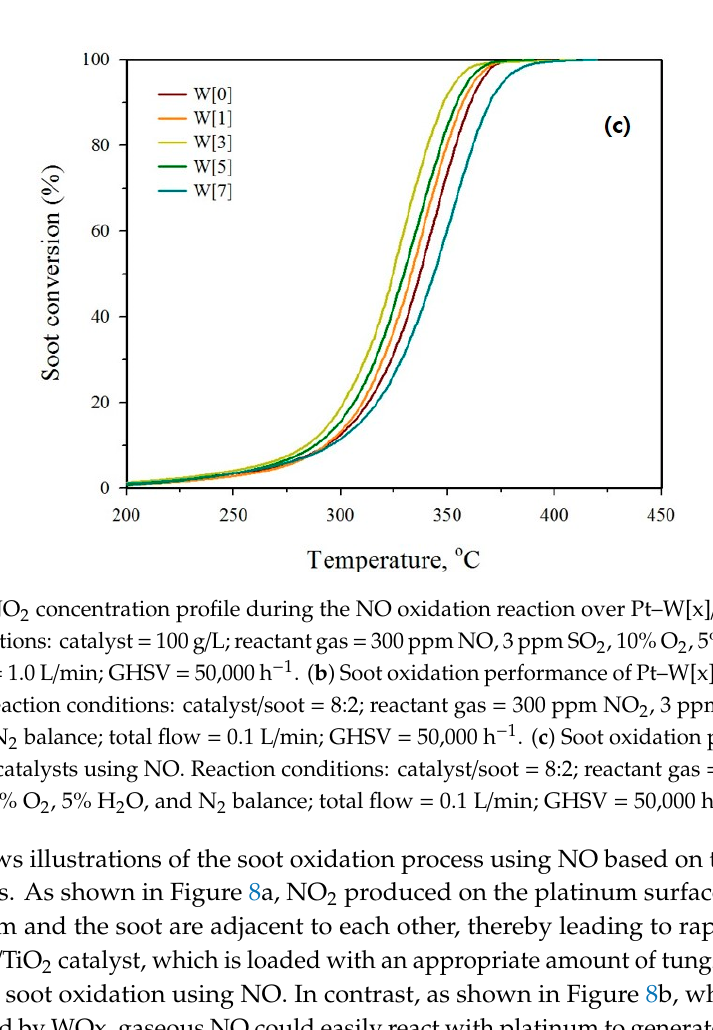
Figure 9. Temperatures corresponding to soot conversion rates of 10% (T 10 (°C)) and 20% (T 20 (°C)) as a function of the tungsten content in Pt–W[x]/TiO 2 catalysts. Reaction conditions: catalyst/soot = 8:2; reactant gas = 300 ppm NO, 3 ppm SO 2 , 10% O 2 , 5% H 2 O, and N 2 balance; total flow = 0.1 L/min; GHSV = 50,000 h − 1 . 3. Materials and Methods 3.1. Catalyst Preparation Degussa P-25 was used as the TiO 2 support, ammonium paratungstate (APT, [(NH 4 )10(H 2 W 12 O 42 )·4H 2 O]) was used as a precursor for tungsten, and platinum was obtained from a platinum solution (A type, 16.6%, SNS Co., Hwa-seong, Korea). In this study, the content of platinum